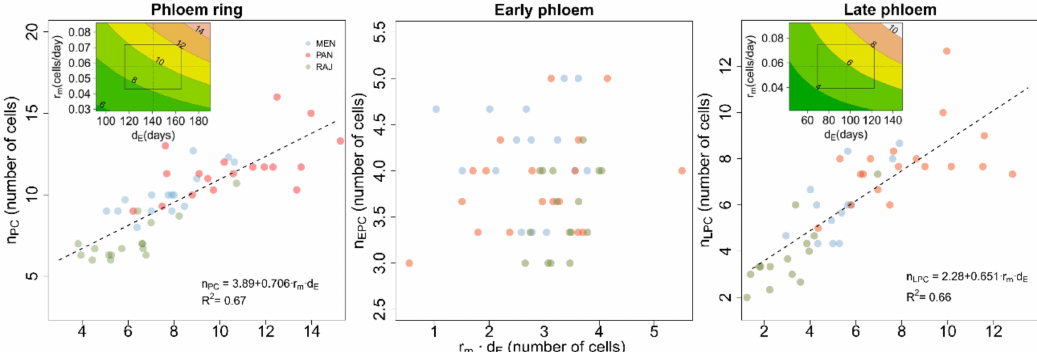
Figure 3. Simple physical model of the total number of phloem cells ( n PC ) number of early phloem cells ( n EPC ) number of late phloem cells ( n LPC ), and the average rate ( r m ) and duration ( d E ) of production of these type of cells in Norway spruce. There was no significant relationship between number of early phloem cells ( n EPC ) and r m *d E . The dashed line represents the regression. Sensitivity analysis of the physical model for the widths of phloem ring and late phloem. The dashed lines represent the means, and the frame delimits the area of the mean ± standard